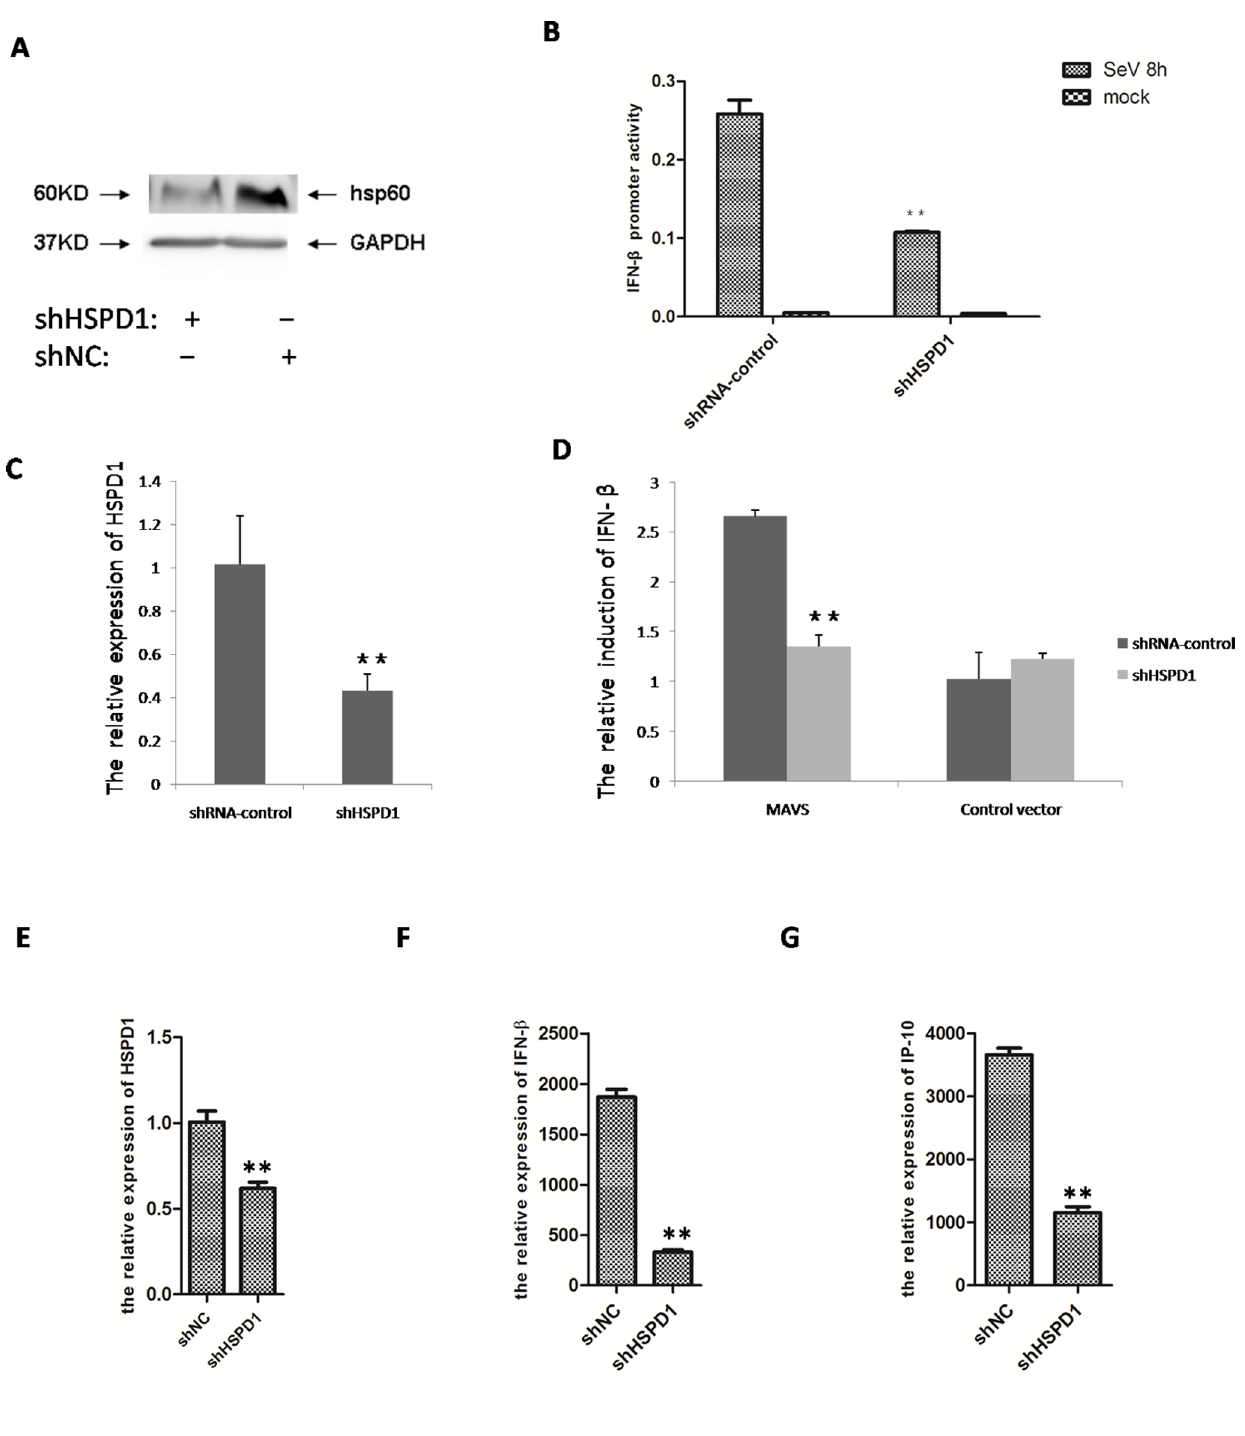
Fig. 4. Knockdown of endogenous HSPD1 impaired IFN- b induction. A. Hela cells transfected with HSPD1 shRNA or control shRNA showed a significant reduction of HSPD1 expression in cells treated with HSPD1 shRNA compared with control shRNA in a Western blot assay. B. SeV infection activated the IFN- b luciferase reporter with control shRNA, and the induction was significantly inhibited with HSPD1 shRNA. C. Hela cells transfected with HSPD1 shRNA displayed significant inhibition of the expression of HSPD1 in comparison with control shRNA in a quantitative PCR assay. D. Knockdown of endogenous HSPD1 significantly inhibited the induction of IFN- b mRNA induced by overexpression of MAVS for 8 h in a quantitative PCR assay.